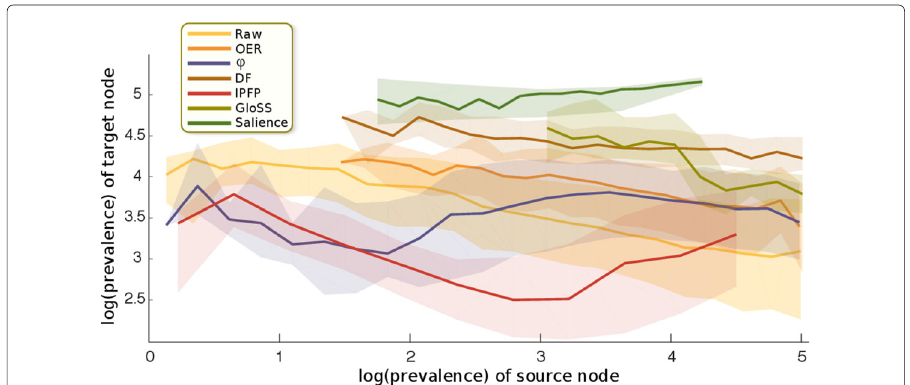
Fig. 5 Comparing prevalences of neighboring nodes. The horizontal axis pertains to the prevalence of the diseases, and the vertical axis depicts the distribution of the prevalences of their out-neighbors. The thick lines denote median values and the shades demarcate 0.25 and 0.75 quantiles. The axes are natural-logarithmic